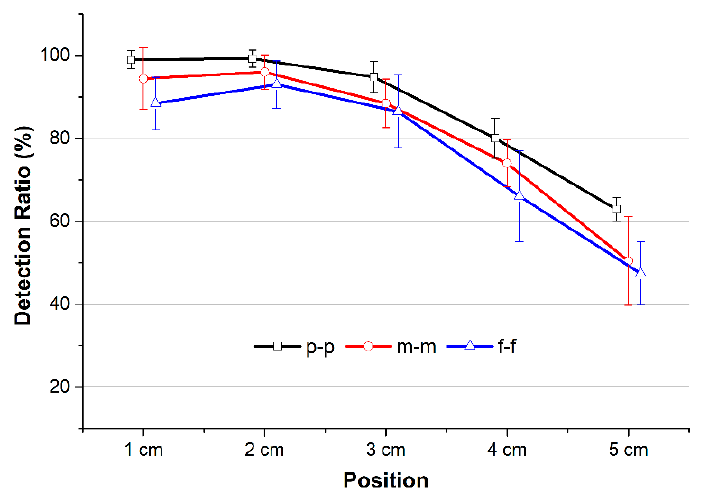
Figure 10. Detection ratio of three types of PTT detections at various locations.